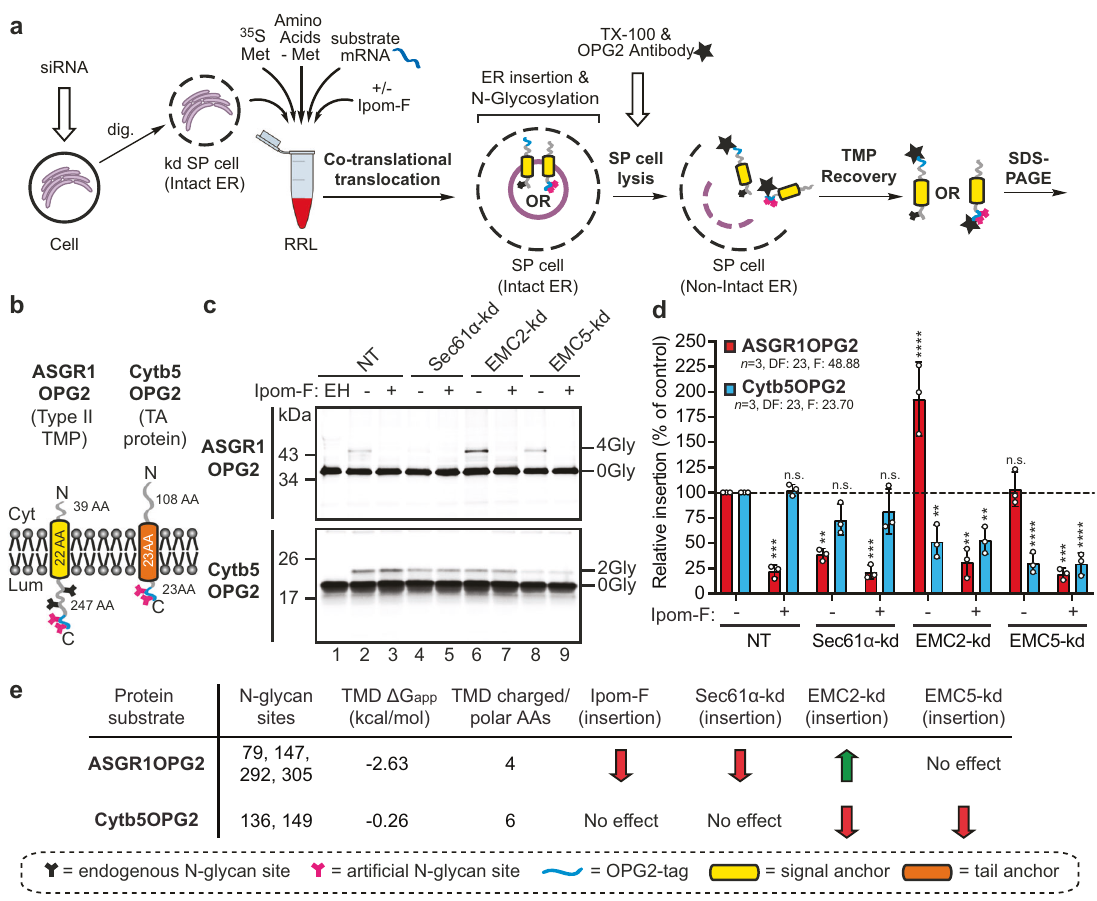
Fig. 3 Sec61 and EMC knock-downs selectively inhibit TMP insertion. a Schematic of the modi fi ed in vitro assay used for analysis of total translation products. Following translation, SP cells depleted of ER membrane components using siRNA were solubilised using Triton (TX-100). Total radiolabelled products (i.e. membrane-associated and non-targeted nascent chains) were recovered by immunoprecipitation via the OPG2-tag and analysed by SDS- PAGE and phosphorimaging. b Schematics of de fi ned model substrates; the type II TMP asialoglycoprotein receptor 1 with an OPG2-tag (ASGR1OPG2) and the TA protein cytochrome b5 with an OPG2-tag (Cytb5OPG2). c ASGR1OPG2 (top panel) and Cytb5OPG2 (bottom panel) synthesised in the presence and absence of 1 µ M Ipom-F using SP cells pre-treated with the indicated siRNA (NT, lanes 1 – 3; Sec61 α -targeting, lanes 4 – 5; EMC2-targeting, lanes 6 – 7; EMC5-targeting, lanes 8 – 9) were recovered and analysed as described in ( a ). d Relative membrane insertion ef fi ciencies were calculated using the ratio of N-glycosylated protein to non-glycosylated protein, relative to the NT control (set to 100% insertion ef fi ciency). Quanti fi cations are given as means ± SEM for independent insertion experiments from separate siRNA treatments performed in triplicate ( n = 3, biologically independent experiments). The statistical signi fi cance of differences in the values for siRNA±Ipom-F translocation ef fi ciency relative to the control (two-way ANOVA, DF and F values shown in the fi gure) were determined using Tukey ’ s multiple comparisons test. e The effects of Ipom-F and Sec61 α , EMC2 and EMC5 knock-downs on ASGR1OPG2 and Cytb5OPG2 insertion are summarised together with biochemical properties of their transmembrane domains (TMDs).